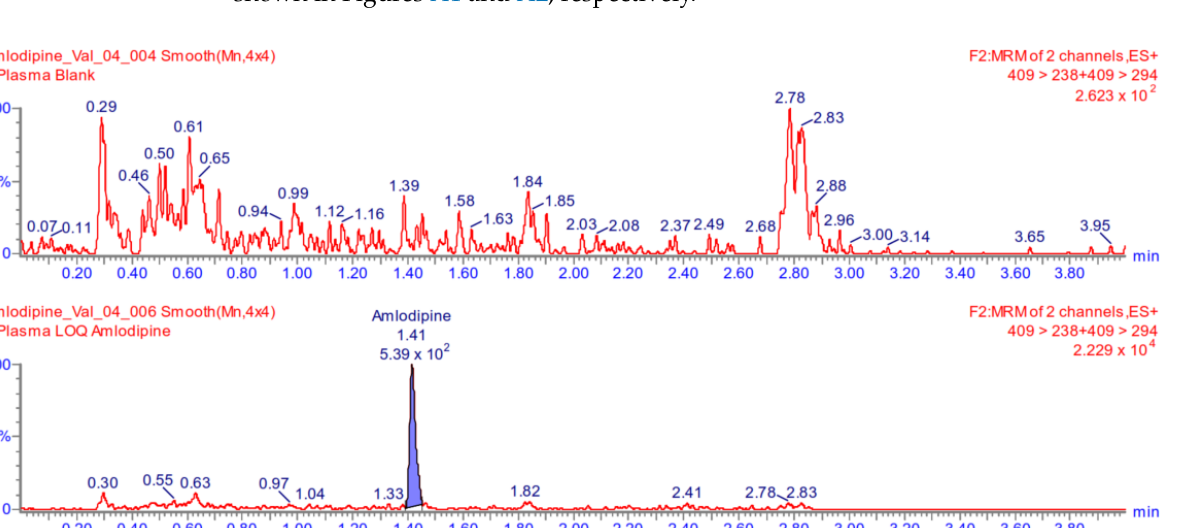
Figure A2. DAML MRM chromatograms of plasma source 1. ( a ) Blank plasma sample. ( b ) Plasma spiked with DAML at 1.0 ng/mL. Although the method is selective with respect to human blood plasma components, there is interference caused by AML giving a false signal in the DAML MRM channel. In Figure A3 MRM chromatograms of human blood plasma samples spiked only with AML at 40.0 ng/mL are shown—see the peak in DAML MRM channel (b) which is at around 20% intensity of AML peak (a).